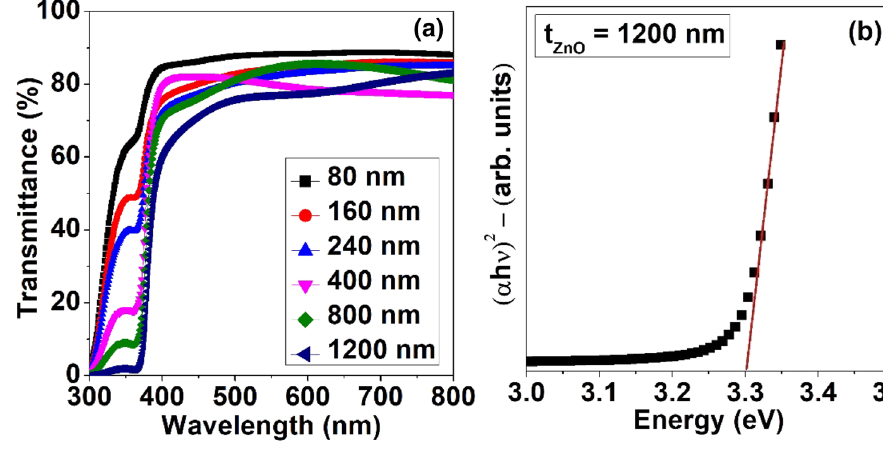
Table 3 Optical bandgap energy of ZnO thin films